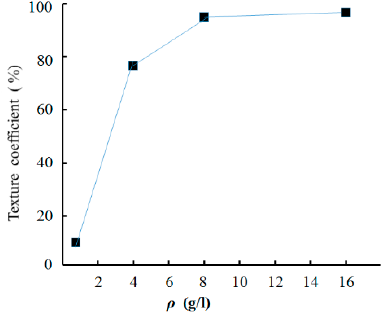
Figure 7. Texture coefficients of (200) crystal orientation with various nanodiamond concentrations in the plating solution.